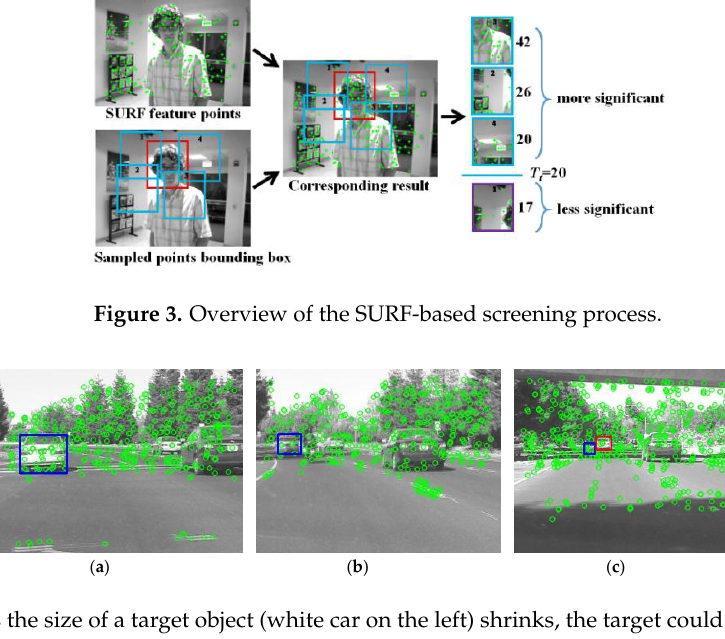
Figure 5. Red line (marked as o) represents the similarity between candidate template and target template when background filters are not used, blue line represents (marked as x) the similarity between candidate template and target template when the background filters are used.